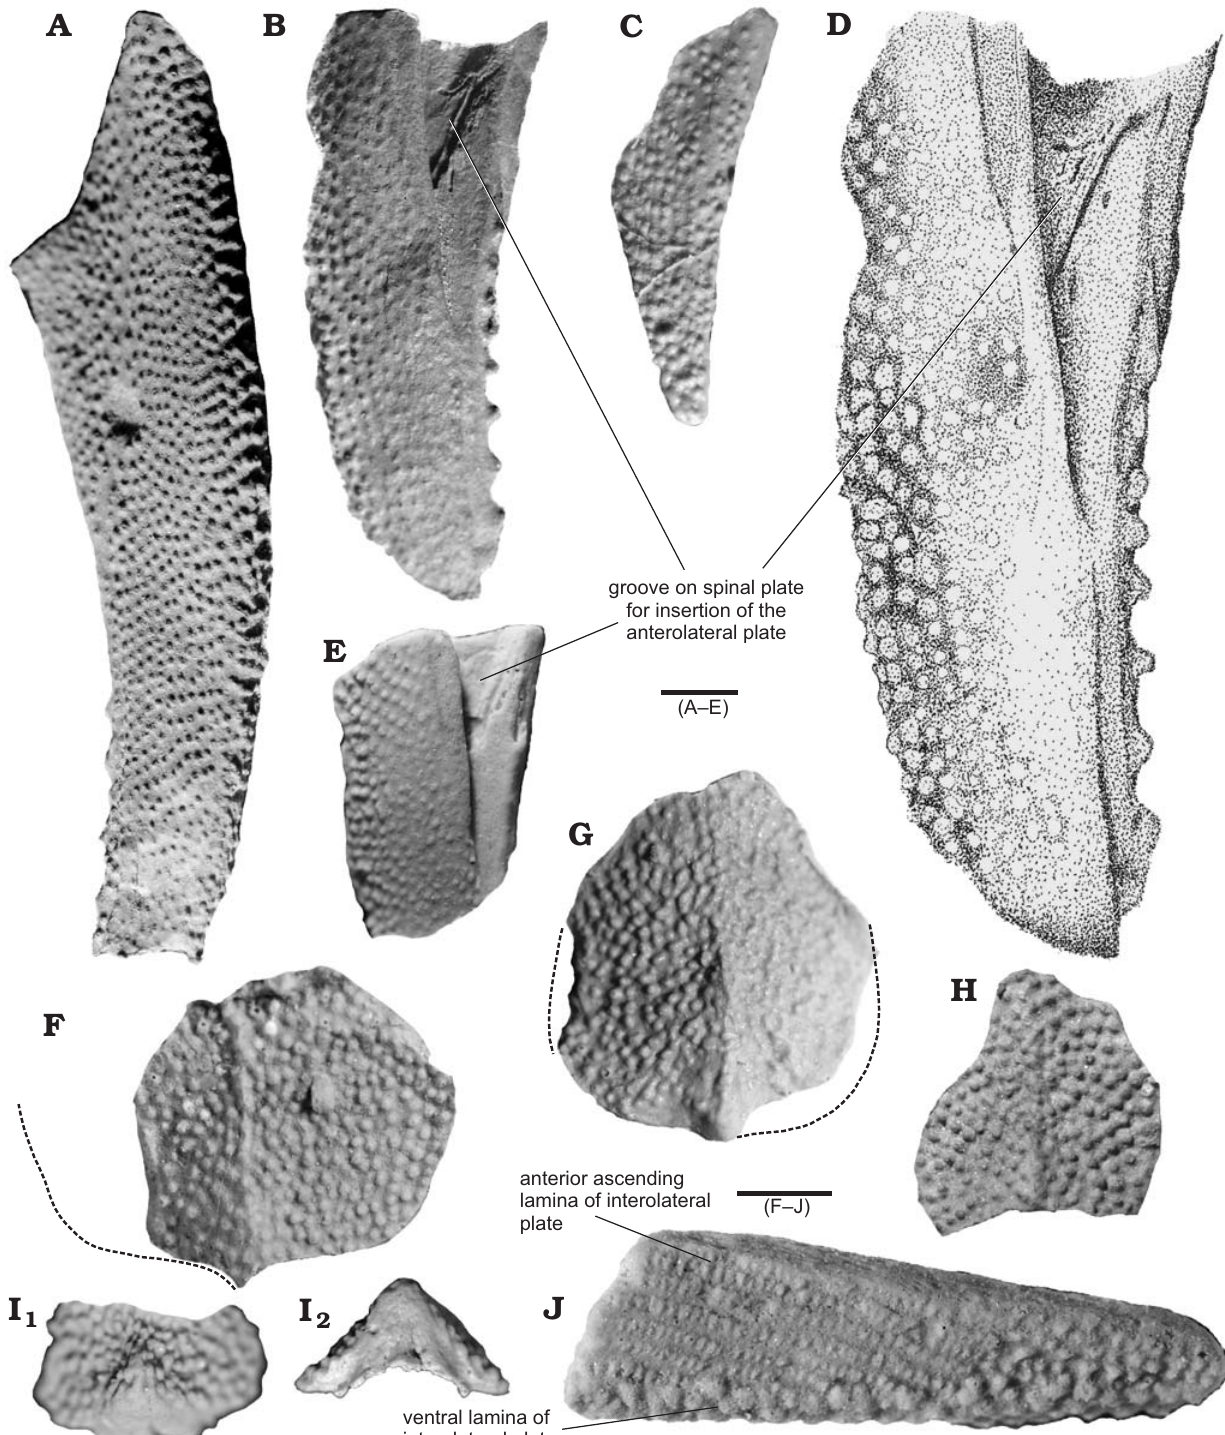
Fig. 4. Thoracic elements of arthrodiran placoderm Kujdanowiaspididae indet. (A–I) and Actinolepidoidei indet. (J) from Lower Devonian (Emsian) of Pod ł azie Hill, Holy Cross Mountains, Poland. A . MZ-VIII/Vp-487, left spinal plate. B . MZ-VIII/Vp-485, left spinal plate. C . Muz PGI 1733.II.285, right spinal plate. D . MZ-VIII/Vp-485, spinal plate (drawing) E . Muz PGI 1733.II.340, right spinal plate. F . Muz PGI 1733.II.442, posterior half of an incom- plete median dorsal plate. G . Muz PGI 1733.II.384, subcomplete median dorsal plate. H . Muz PGI 1733.II.81, incomplete median dorsal plate. I . MZ-VIII/ Vp-520, postmedian dorsal scute (tail cover) in dorsal (I 1 ) and posterior (I 2 ) views. J . Muz PGI 1733.II.174, right interolateral plate. Scale bars 10